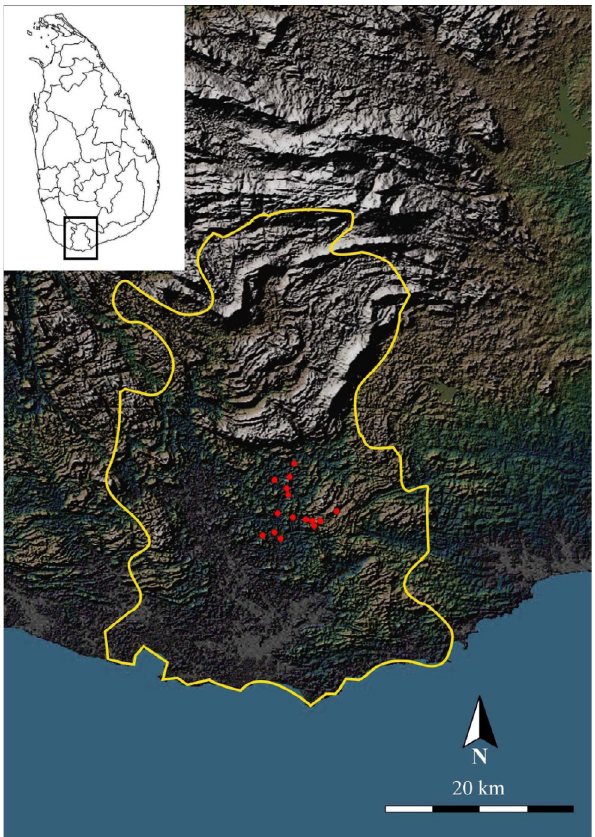
Figure 1: Collection sites in Matara district of Sri Lanaka; collection sites are indicated by red